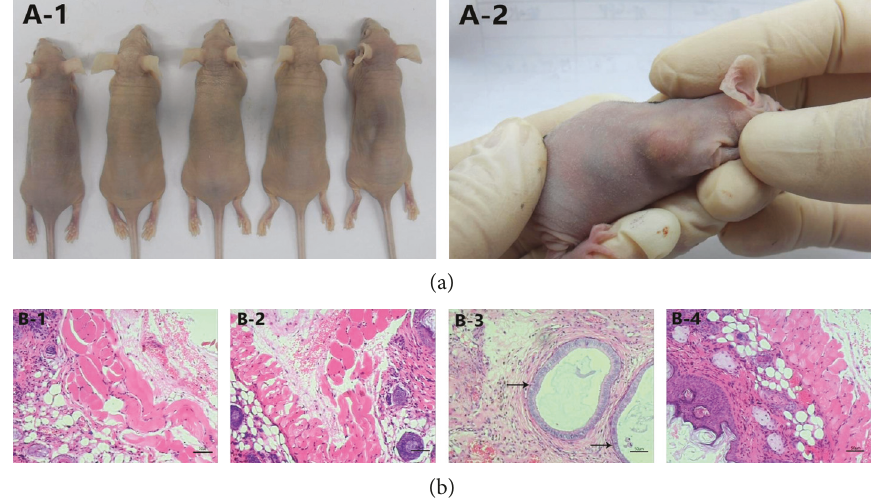
Figure 3: EMSCs and ectopic endometrium tumourigenicity. (a) Macroscopic observation. (A-1) Absence of tumour formation from inoculated EMSCs. (A-2) Lesion formation from ectopic endometrium inoculation. (b) H&E staining. (B-1) EMSC injection site after H&E staining in the EMSC group. (B-2) NS injection site after H&E staining in the EMSC group. (B-3) Ectopic endometrium injection site after H&E staining. Arrow indicates endometrial glands. (B-4) NS injection site after H&E staining in the ectopic endometrium